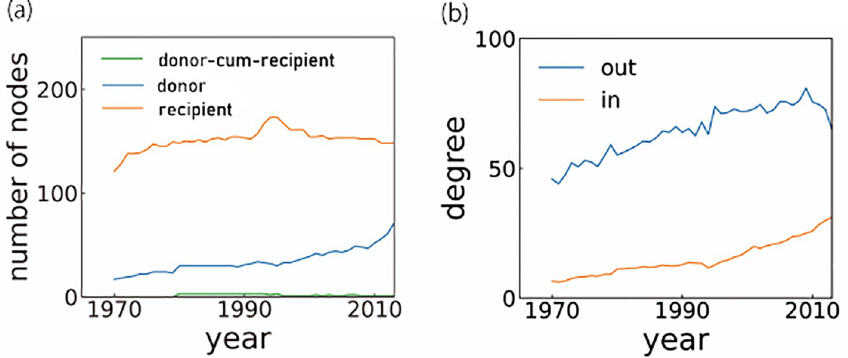
Fig 1. Time evolution of the local network quantities of FANs. (a) The numbers of donors, recipients, and nodes with both incoming and outgoing edges (donor-cum-recipients). (b) The average out-degree of donors, and the average in-degree of